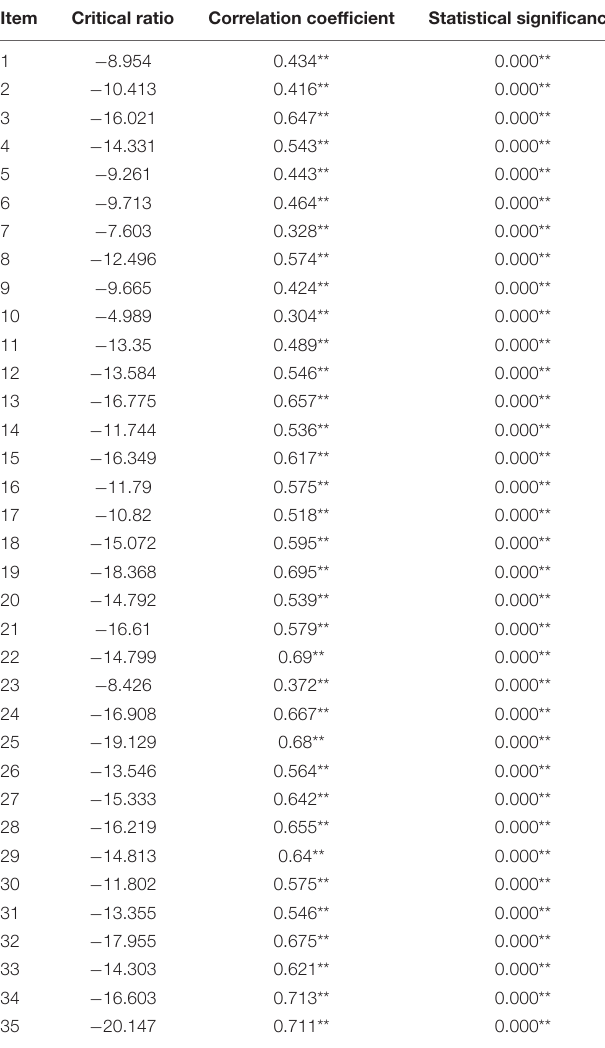
TABLE 7 | Item analysis results in Study 3 ( n = 471). TABLE 8 | Results of component matrix after rotation in Study 3 ( n =